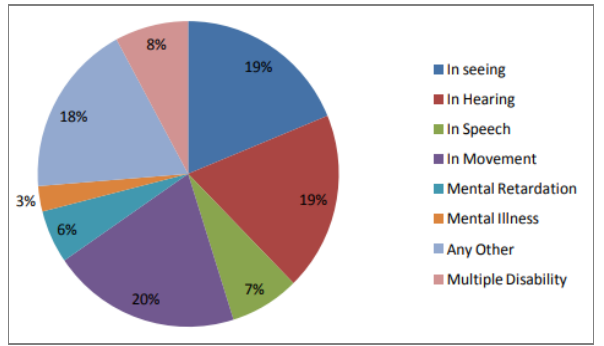
Figure. 1. Percentage of disabled persons in India - Census 2011